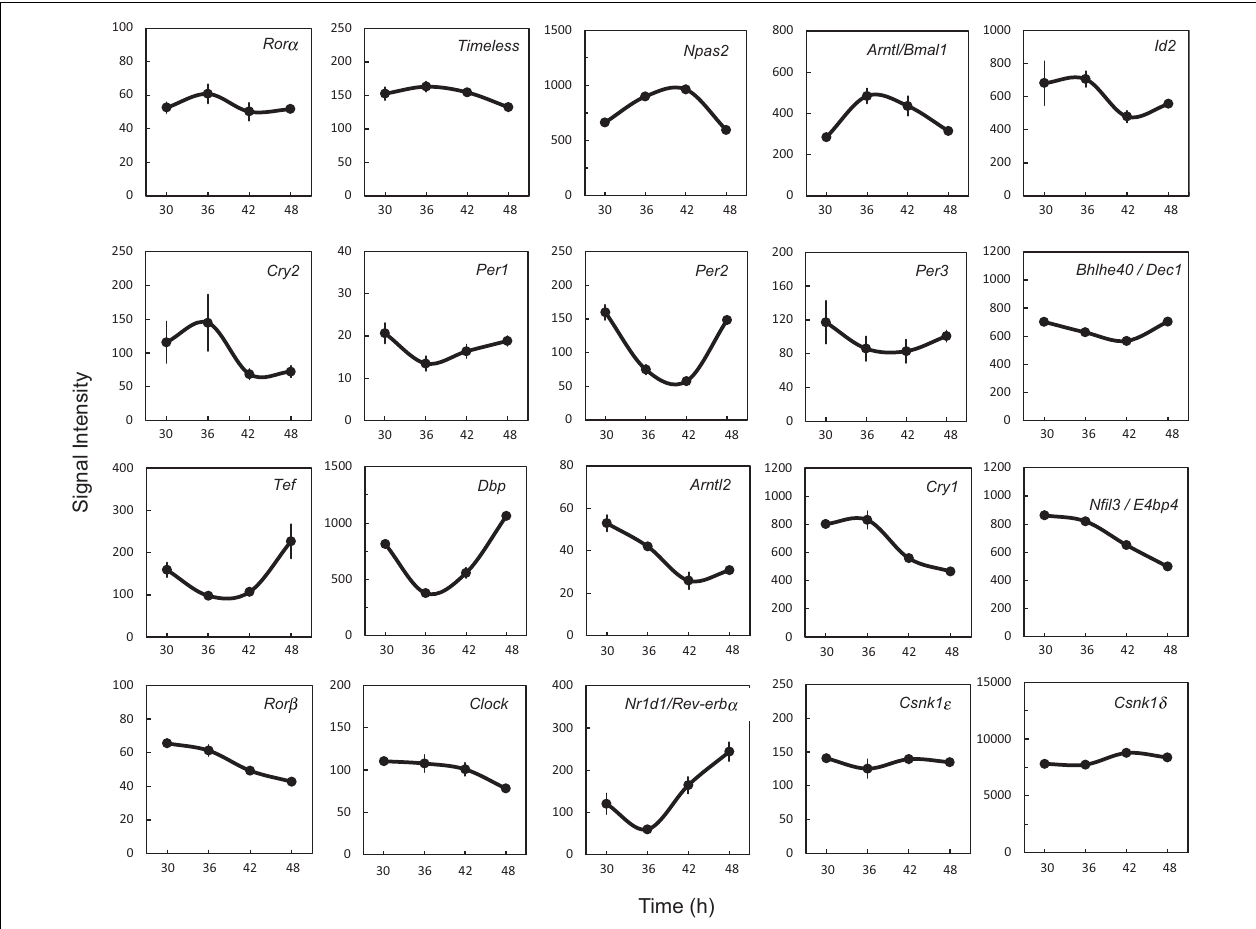
FIGURE 2 | Expression profiles of clock genes and protein kinase genes in the uterus endometrial stromal cells of pregnant rats after dexamethasone synchronization . Each value represents the means ± SEM ( n = 3) of signal intensity from the microarray results.